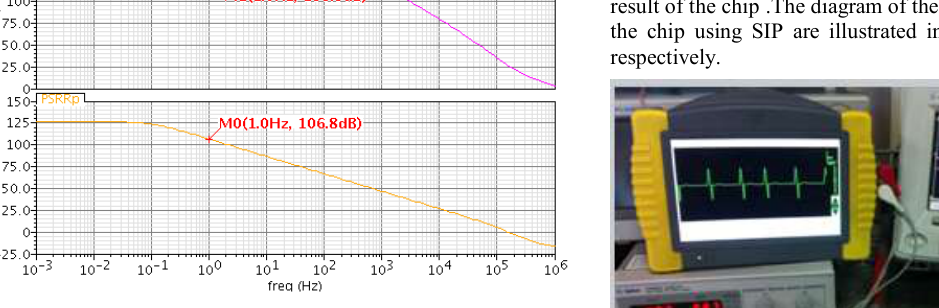
Figure 5. CMRR and PSRR of the main amplifier